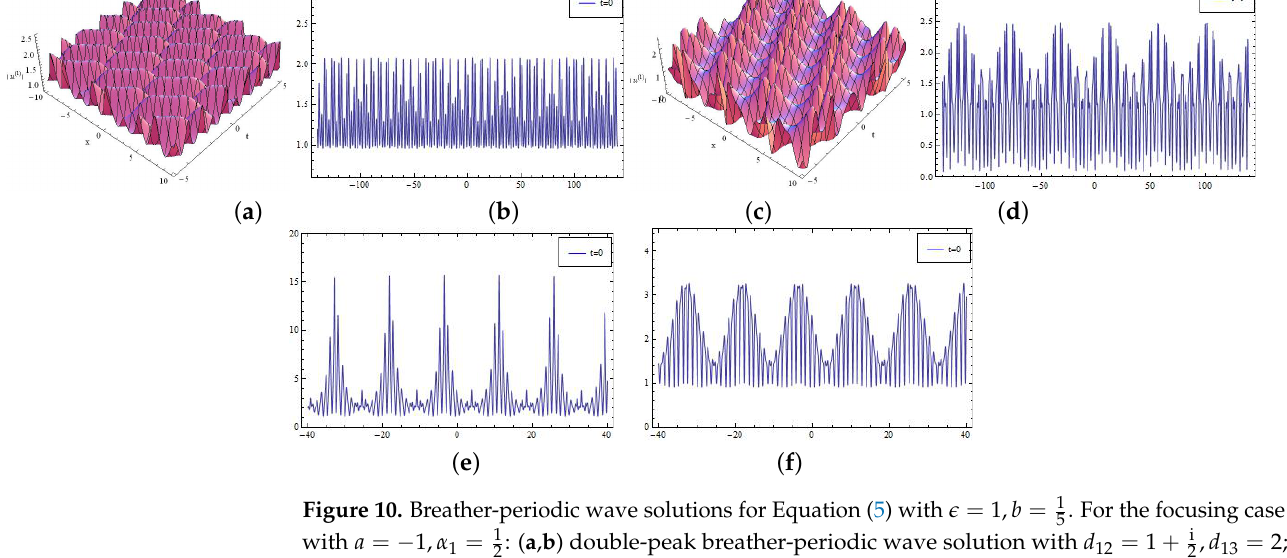
Figure 9. Periodic wave solutions for Equation (5) with d 13 = 2, b = 1 (cid:101) = 1, a = − 1: ( a ) M-shaped periodic wave with d 12 = i, α 1 = 2; ( b ) W-shaped periodic wave with d 12 = i, α 1 = − 2; ( c ) classical periodic wave with d 12 = 1, α 1 = 2; for the defocusing case with (cid:101) = 1, a = 1: ( d ) W-shaped periodic wave with d 12 = i, α 1 = 2; ( e ) classical periodic wave with